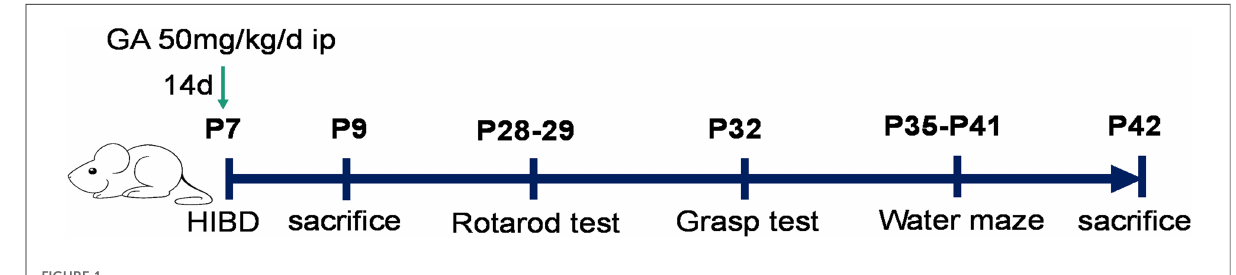
FIGURE 1 The timeline of HIBD animal experimental